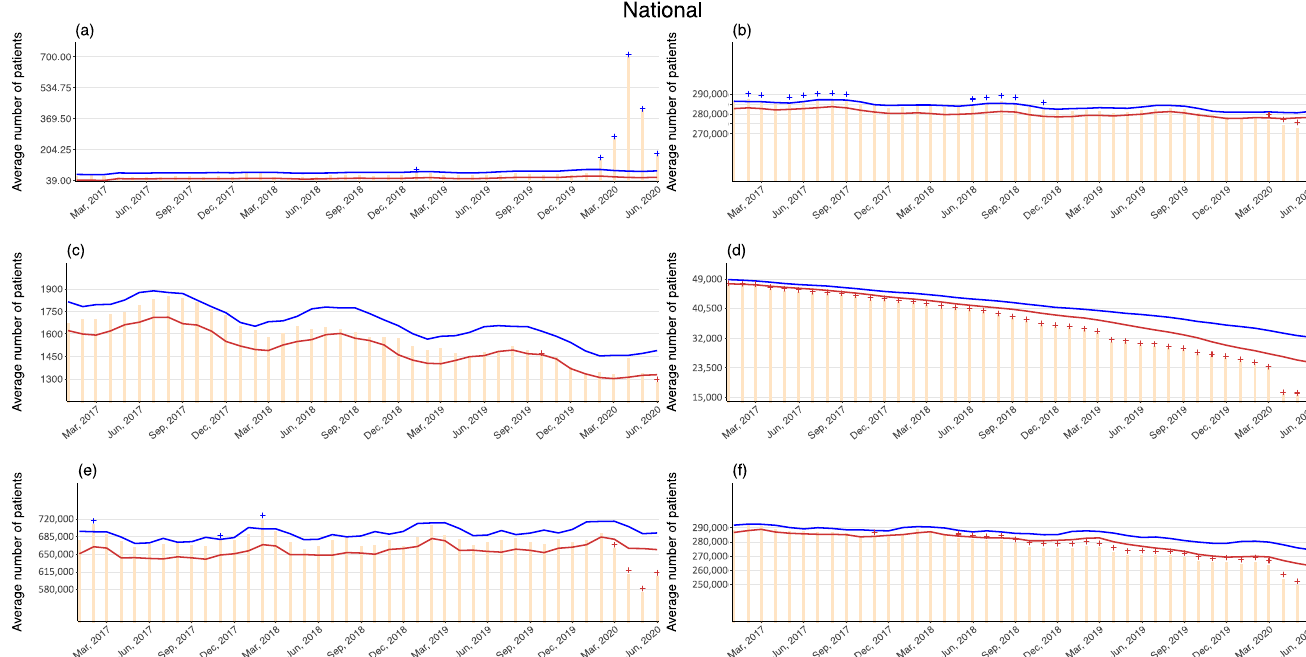
Figure 2. Observed and 95% upper and lower bounds of the expected monthly average number of hospitalized patients per day, in Japan up to June 2020 (( a ): Infectious disease care beds; ( b ): Psychiatric care beds; ( c ): Tuberculosis care beds; ( d ): Long-term care beds; ( e ): General beds; and ( f ): Long-term care beds covered by long-term care insurance). Orange: Observed; blue: Upper bound; red: Lower bound; cross symbols indicate months with the observed exceeding or falling the 95% upper or lower bounds.